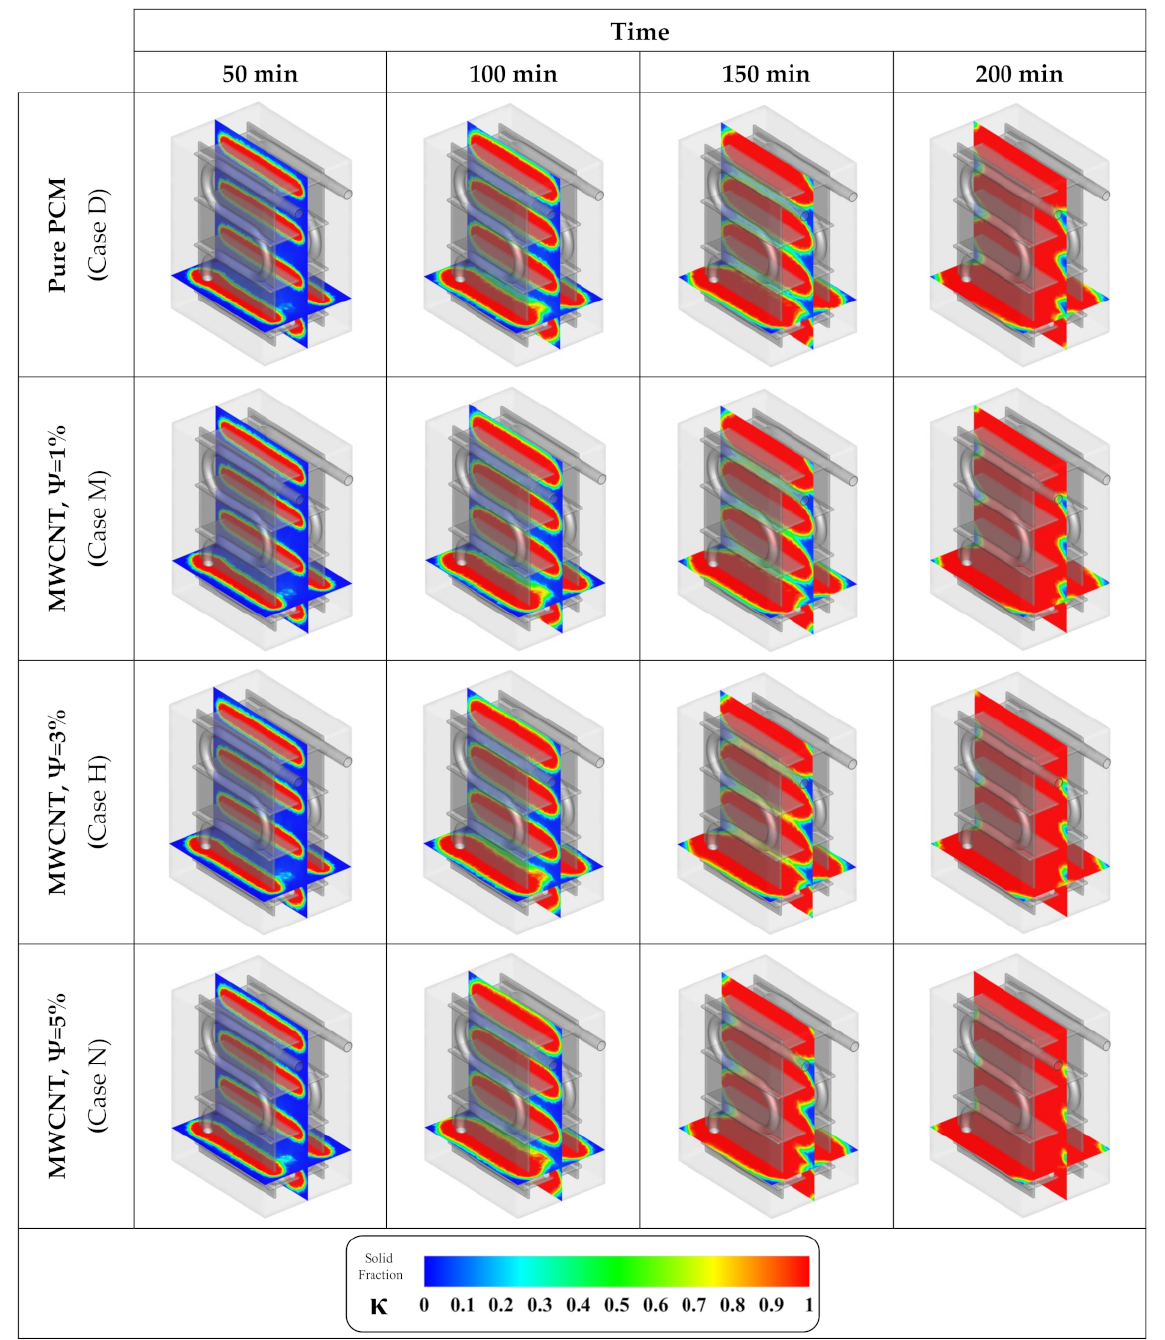
Figure 12. Contours of solid fraction advancement at different volumetric concentrations of MWCNT